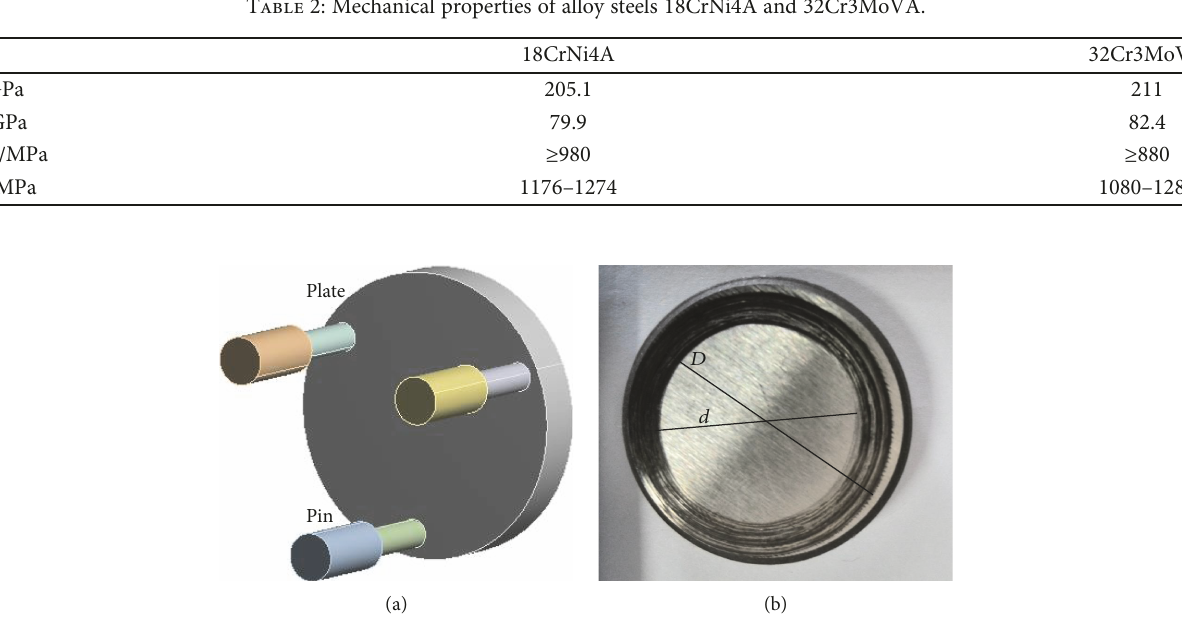
Figure 1: Experimental specimen con fi guration and worn trace: (a) scheme of pin-on-plate couple; (b) worn trace formed on plate